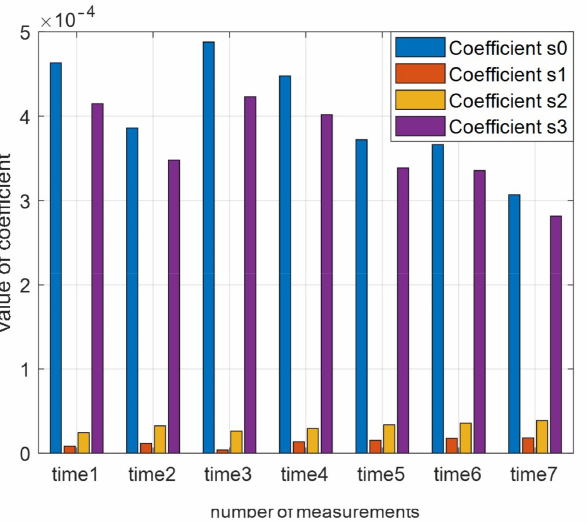
Figure 11. Scattering chart of a linear polarized wave from a trihedral reflector obtained at different time intervals during one